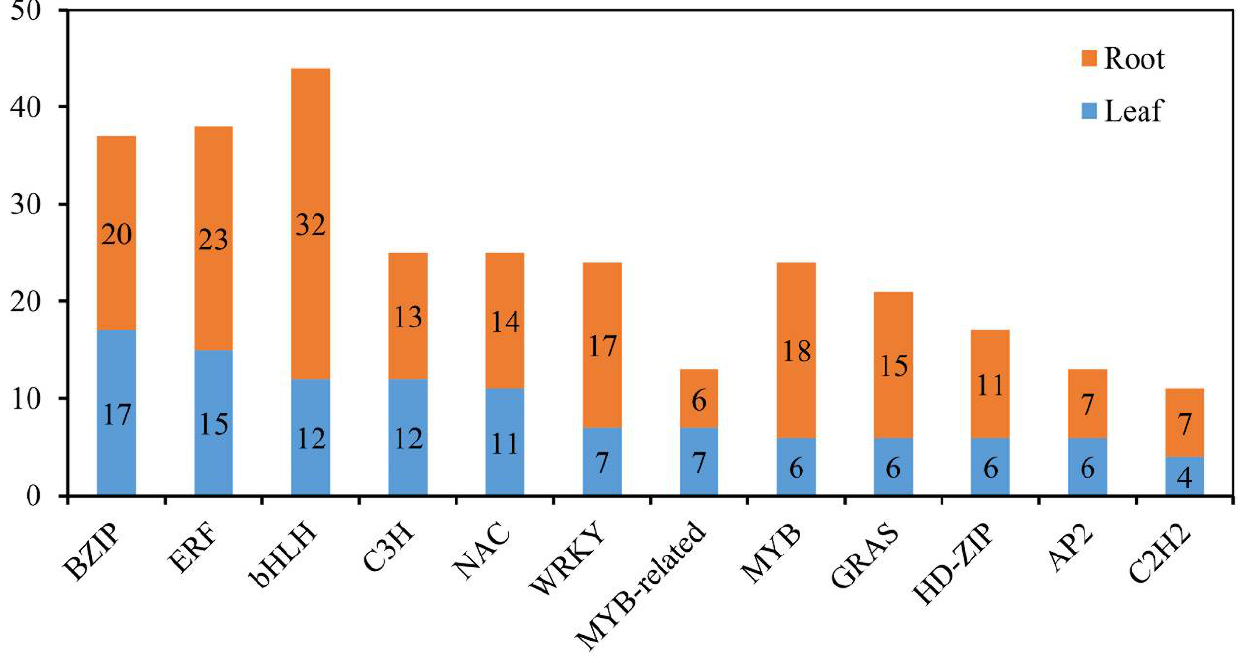
Figure 10. Distribution of the top 12 TFs responsive to salinity stress in common vetch.